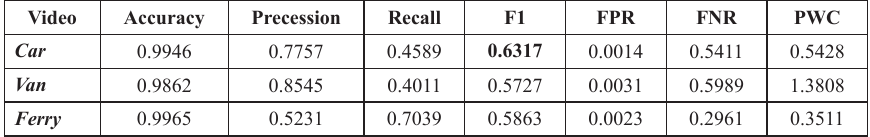
Table 4. Performance metrics results of applying LOBSTER